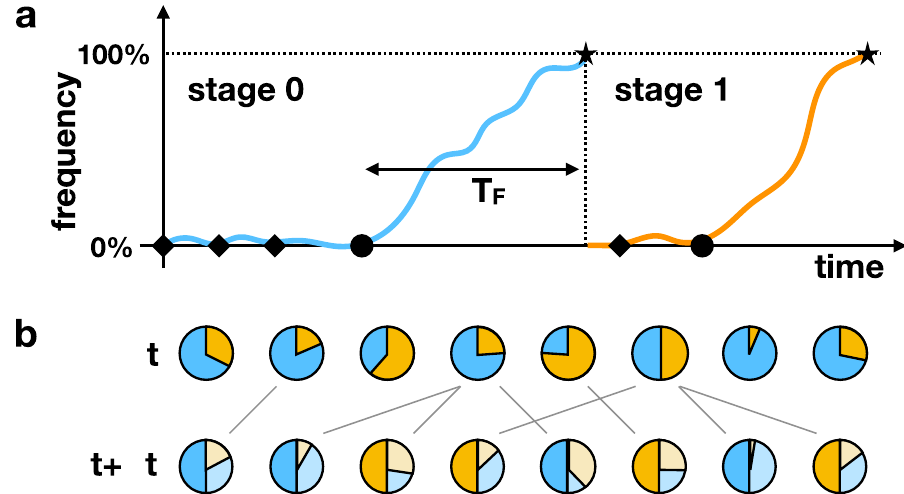
Fig 1. (a) Origin-fixation model at the population scale, showing a transition between two stages of a grammaticalisation cycle (set out in Table 1). Innovations are repeatedly introduced to the population; most fail (diamonds), but some successfully originate a change that propagates and goes to fixation (circles). The fixation time T F is a random variable (see text). (b) Underlying individual-based (Wright-Fisher) model. Individuals are characterised by the frequency with which they use the innovation (orange portion of pie charts). In the case shown, individuals update their innovation frequencies by retaining a fraction 1 − � their existing value, and acquiring the remaining fraction � through exposure to one other member of the speech community. In the figure, � ¼ 1 illustrative purposes. The two levels of description are connected by averaging over the individual speaker-level innovation frequencies in the Wright-Fisher model to obtain the population-level frequency plotted for the origin- fixation